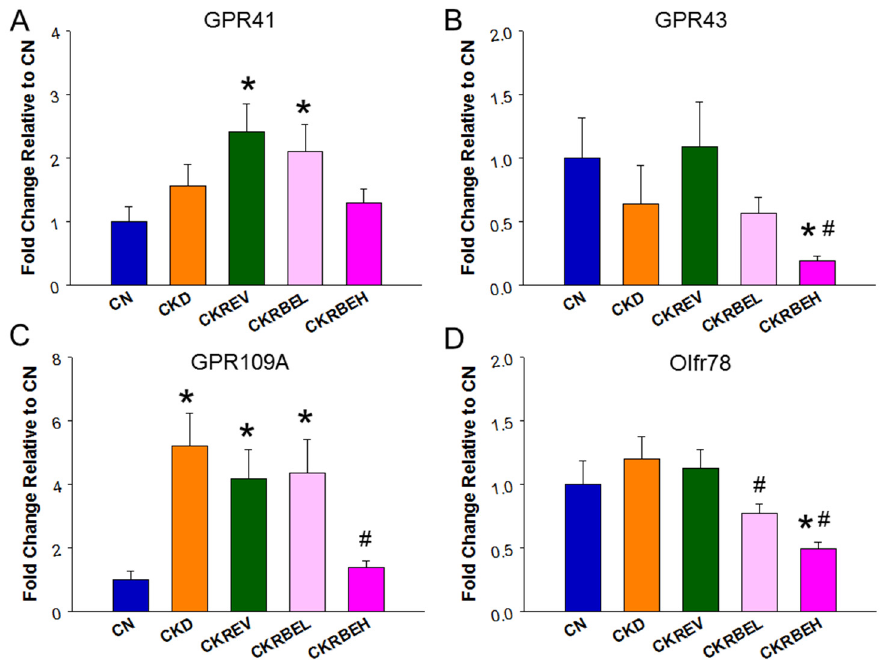
Figure 3. Effect of adenine-induced chronic kidney disease (CKD), resveratrol, or resveratrol butyrate